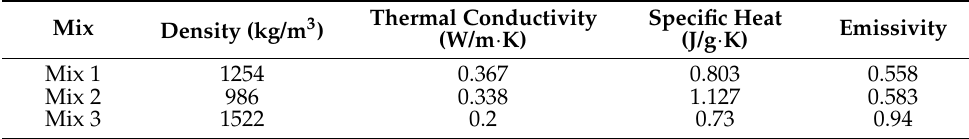
Table 1. Properties of the concrete mix [31].